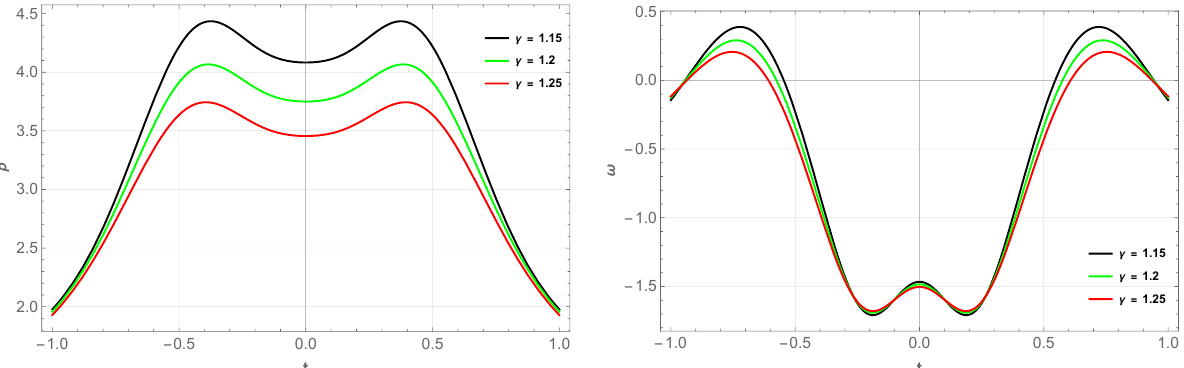
Figure 6. Behavior of energy density ( left panel ) and EoS parameter ( right panel ) versus cosmic time t , λ = 1.01.